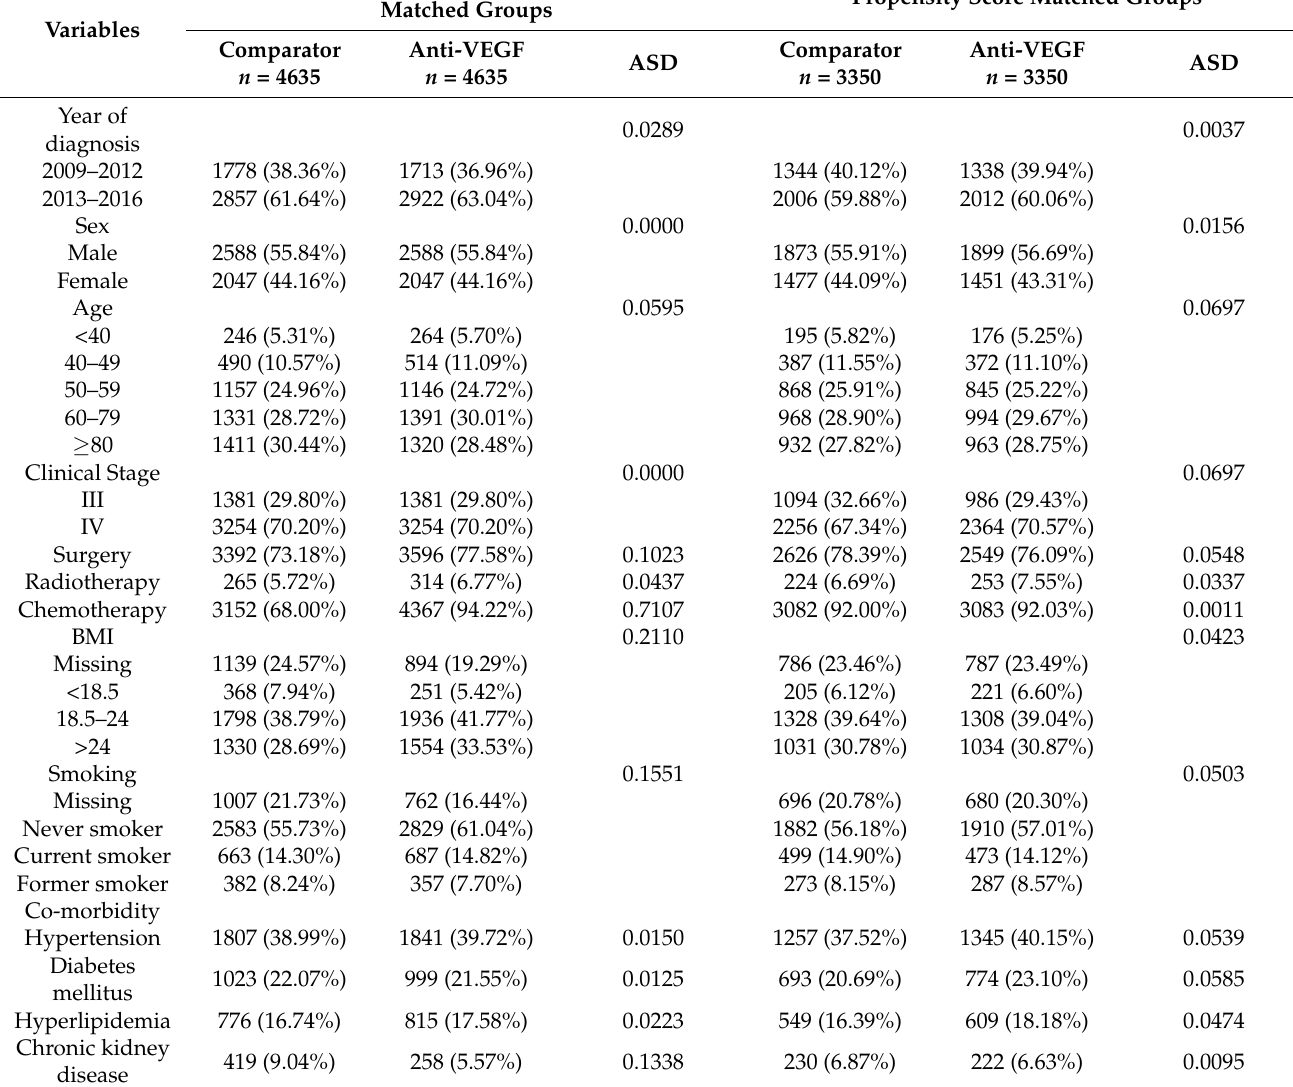
Table 1. The baseline characteristics among time-distribution matched and propensity score matched study groups.